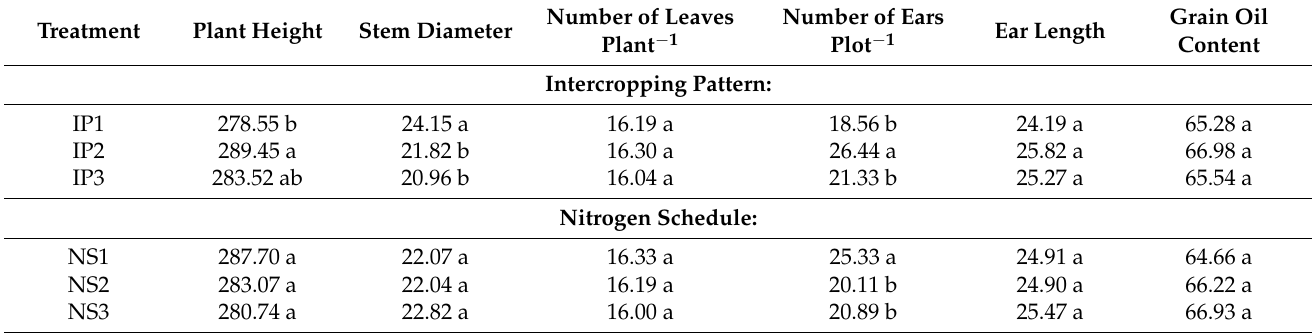
Table 1. Variations of plant height (cm), stem diameter (mm), number of leaves plants − 1 , number of ears plot − 1 , ear length (cm), and grain oil content (g kg − 1 ) of maize crop as affected by the intercropping pattern and nitrogen schedule combined over the two growing seasons.